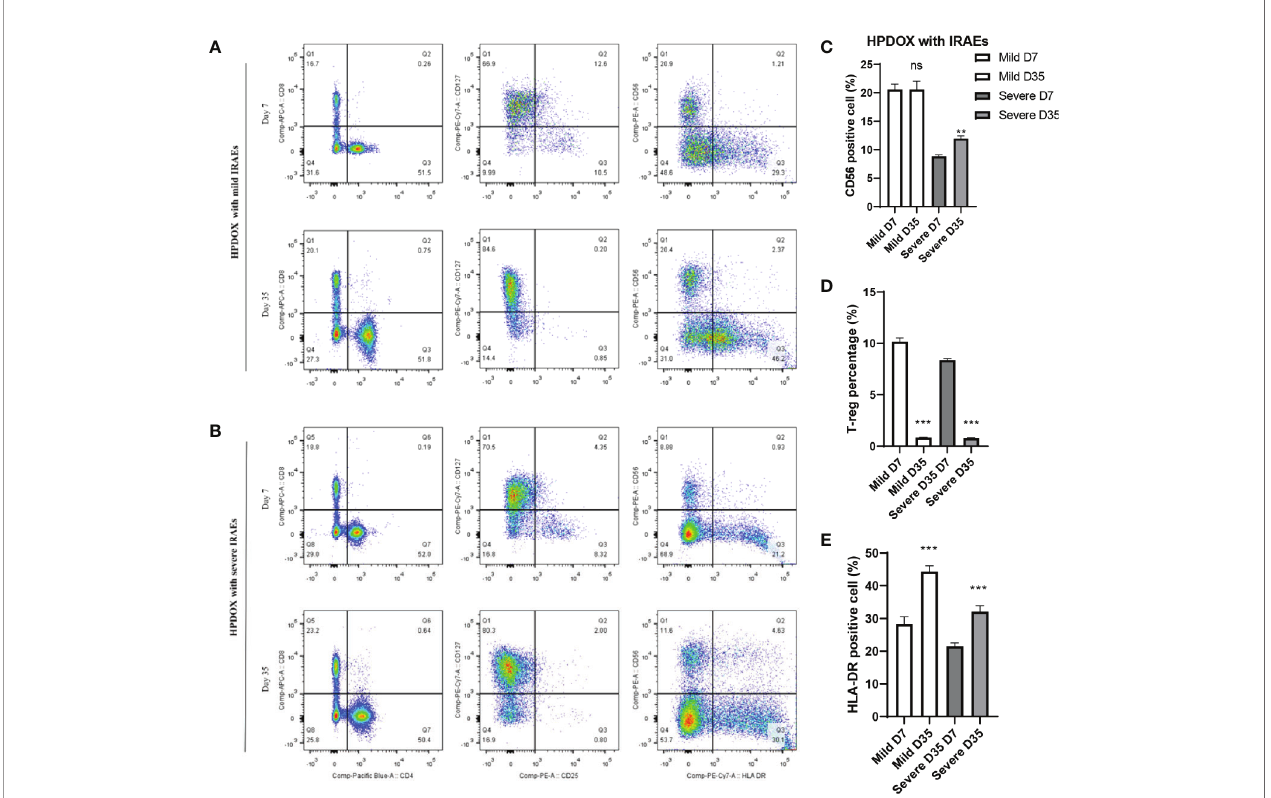
FIGURE 5 | The degree of IRAEs may be related to CD56+ expression in HPDOX. (A, B) The population of CD4+, CD8+, the CD25+CD127 − Treg cells, CD56, and HLA-DR in both mild and severe IRAEs groups after the intervention of ipilimumab. (C) There was no signi fi cant difference in the CD56 expression in the mild IRAEs group, although increased in the severe IRAEs group. (D, E) The CD25+CD127 − Treg cells were signi fi cantly decreased, while the HLA-DR expression was increased in both mild and severe IRAEs groups. There were six mice in each group. Data were represented as mean ± SD. ** P < 0.01, *** P <